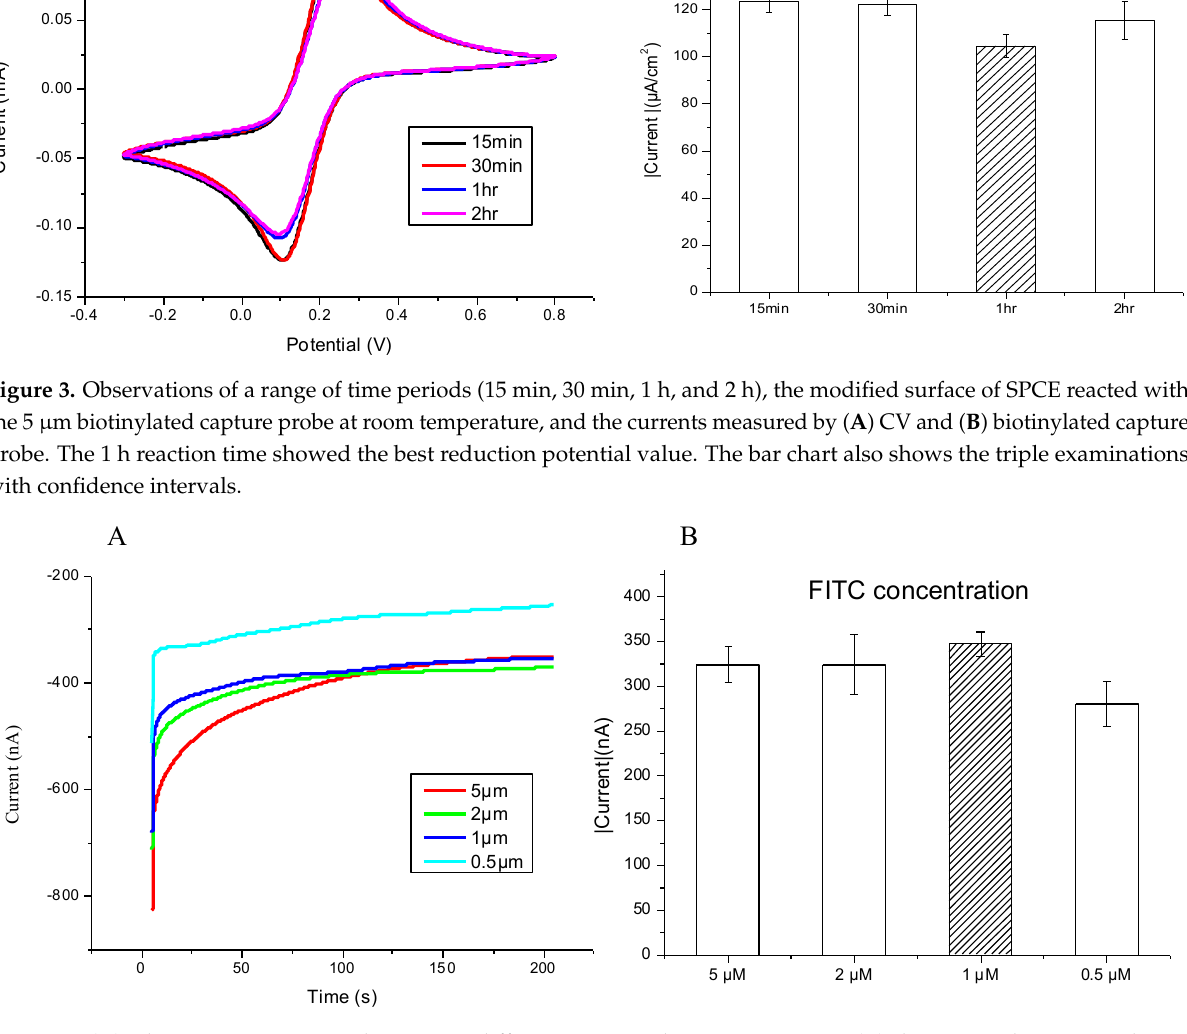
Figure 4. ( A ) Chronoamperometric diagram in different FITC probe concentrations; ( B ) the terminal current value in different concentrations of FITC probe by chronoamperometry, and 1 µ m of FITC showed the best stability. The bar chart shows the triple examinations with confidence